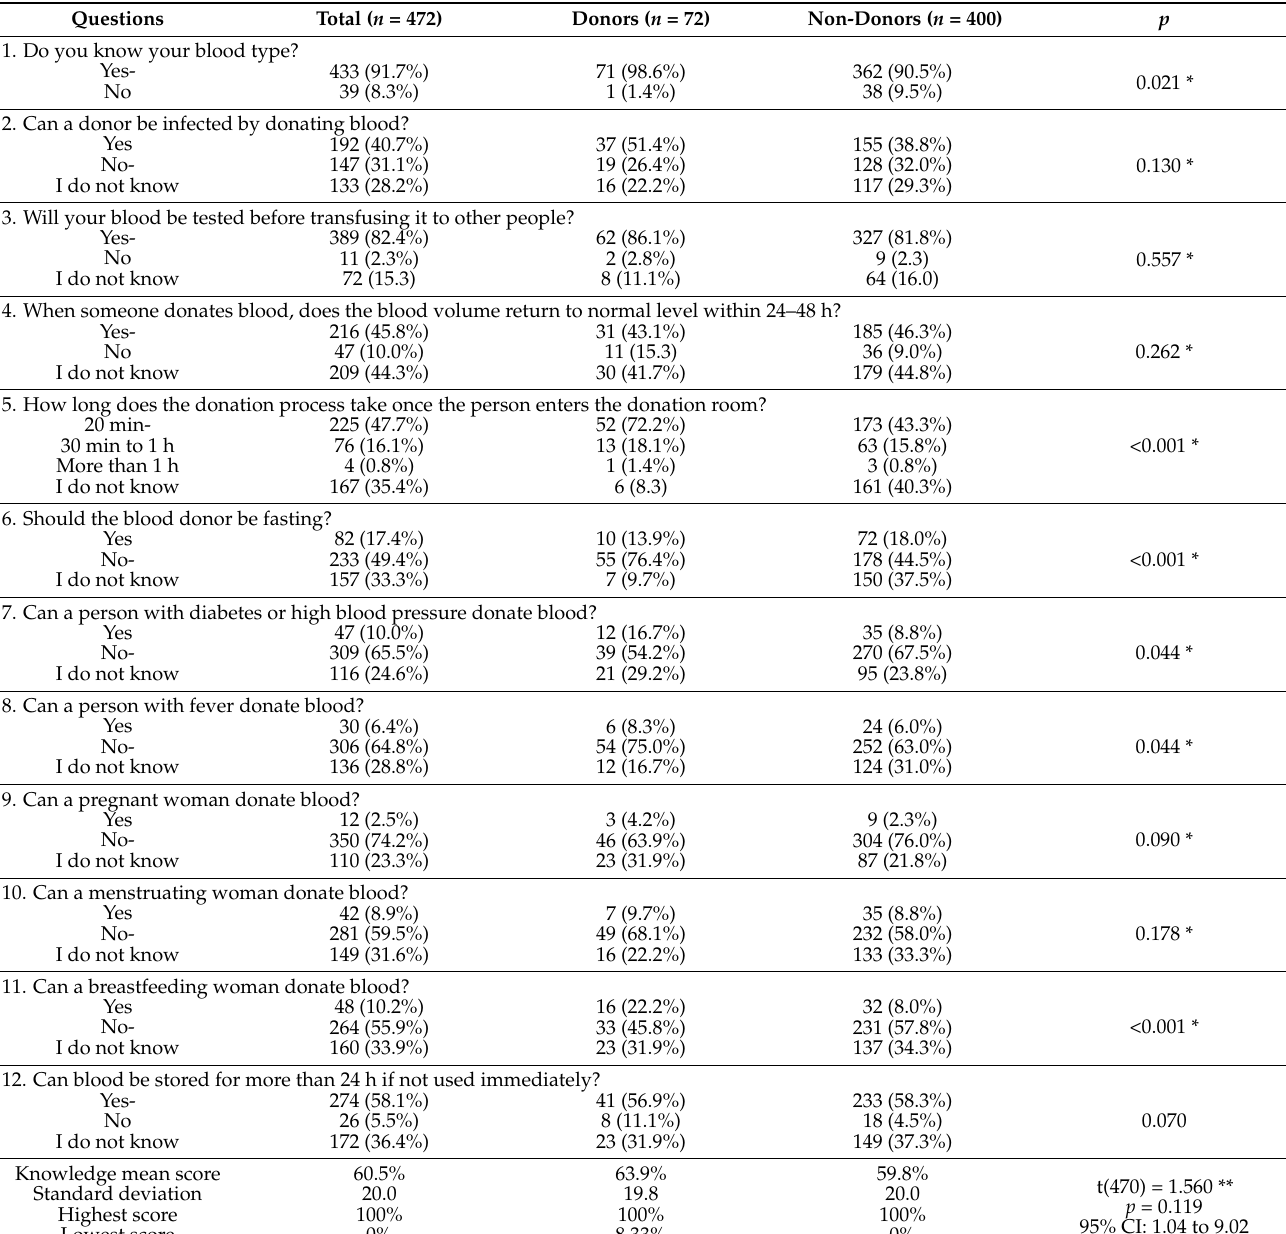
Table 2. Knowledge level toward blood donation among blood donors and non-blood